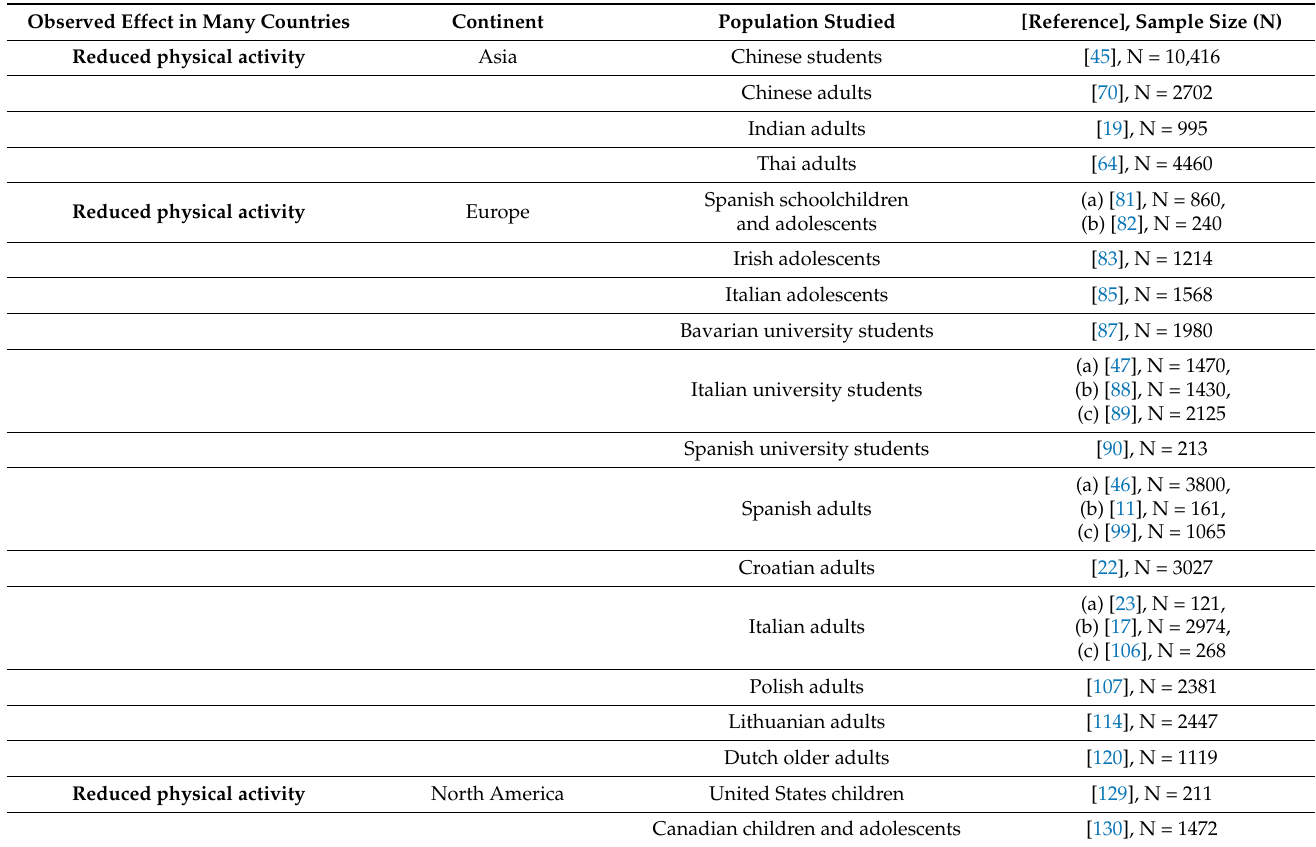
Table 8. Brief summary of similar trends during the pandemic (i.e., the same effects observed in different